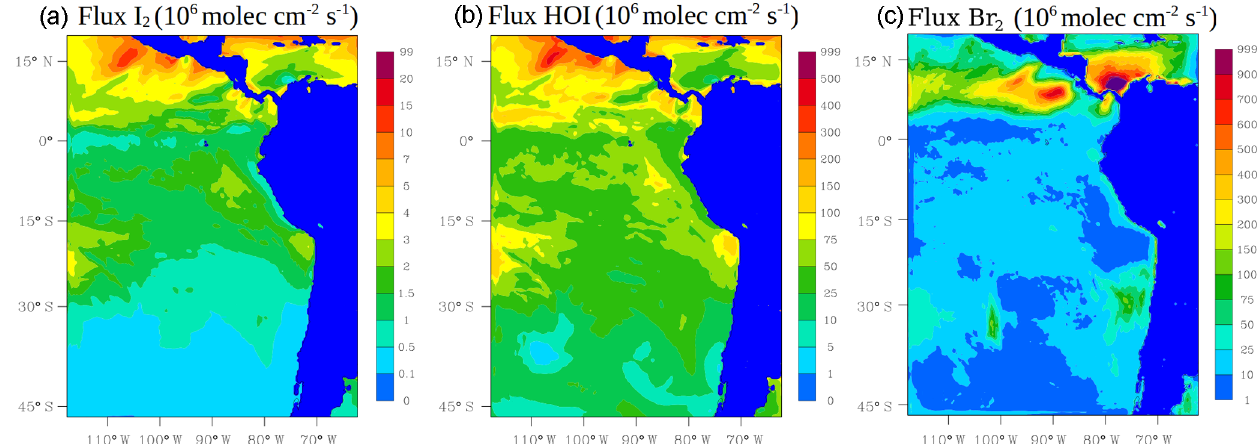
Figure 2. Mean oceanic surface fluxes for inorganic iodine: I 2 (a) and HOI (b) . The column-integrated fluxes for inorganic bromine (Br 2 , c ) from the debromination process during January and February 2012 are also shown. Values are given in 10 6 moleccm − 2 s − 1 .